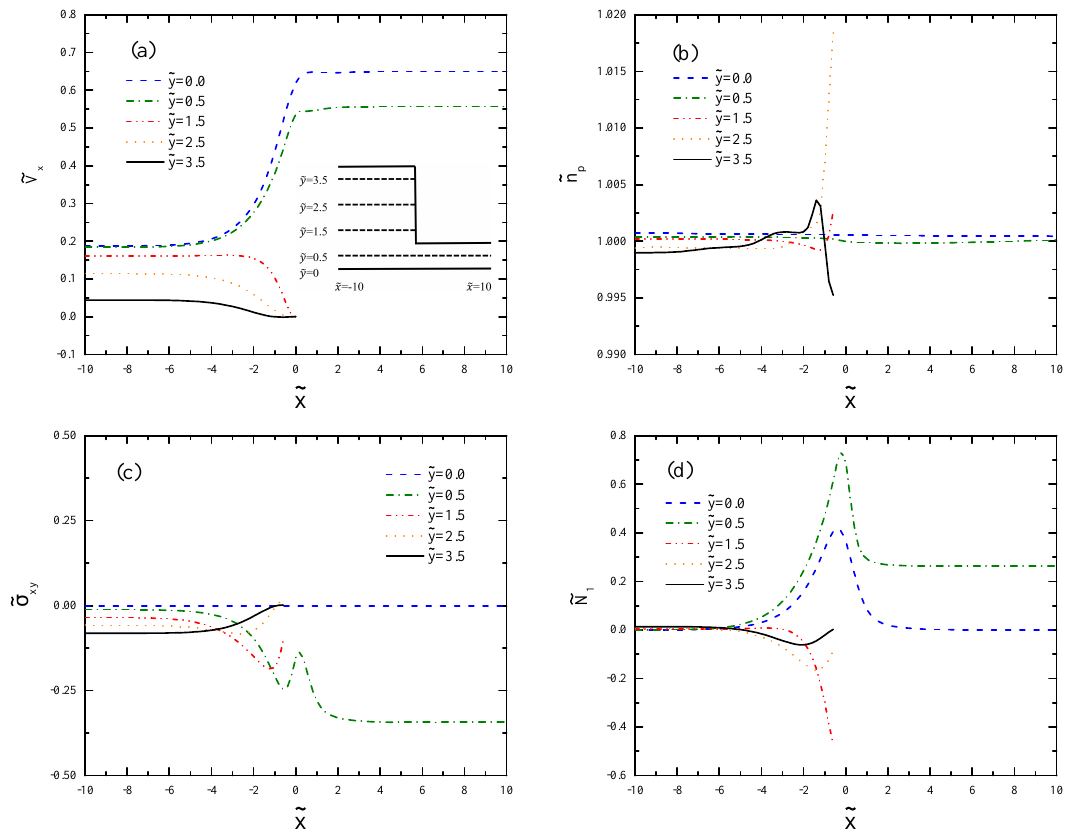
Figure 9. Profiles of ( a ) axial velocity, ( b ) polymer number density, ( c ) shear stress, and ( d ) first normal stress difference for De = 0.5 at horizontal cross-sections ˜y = 0, 0.5, 1.5, 2.5, and